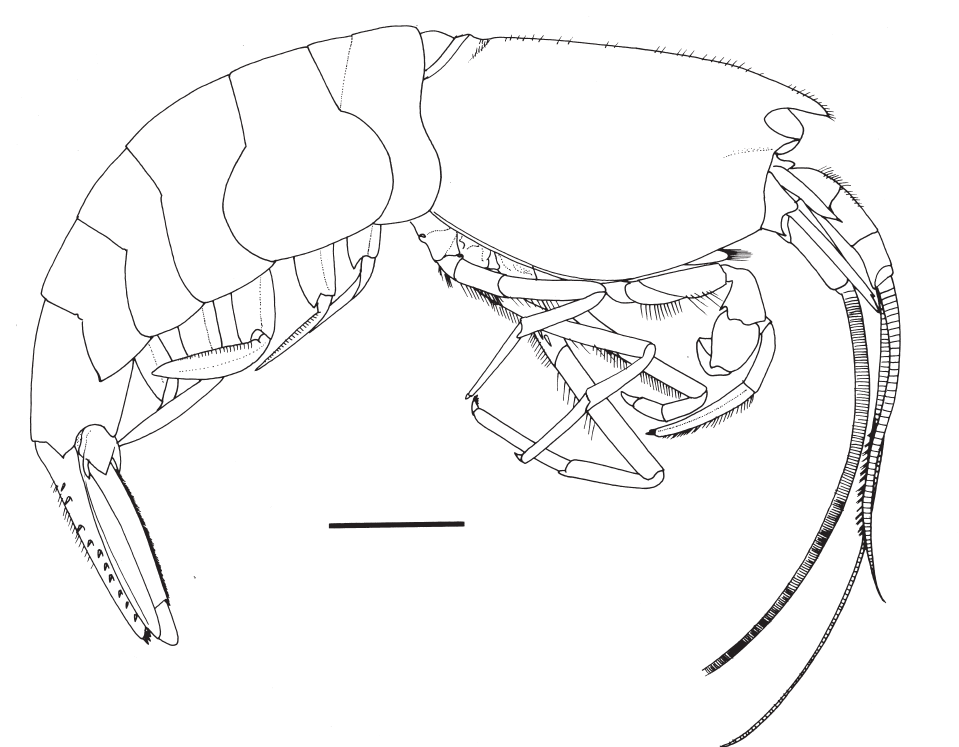
Description : Body (Fig. 1) moderately robust for alvinocaridids. Integument smooth, thin, but not